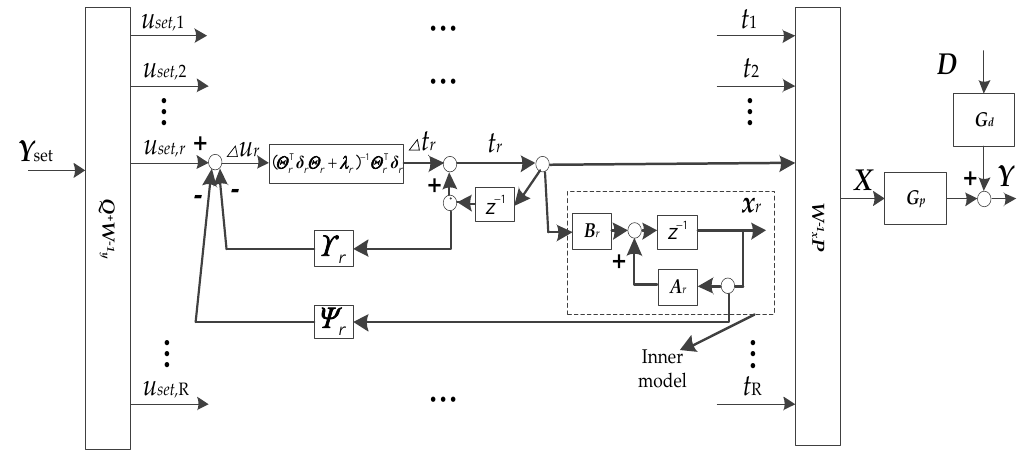
Figure 2. Structure of state space MPC control scheme in the PLS framework.